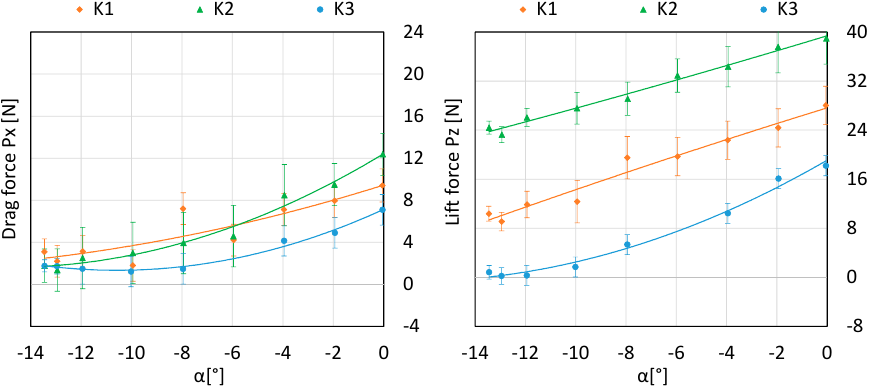
Figure 10. A juxtaposition of the impact of the angle of attack on the value of the drag force and lift for the three configurations under scrutiny.